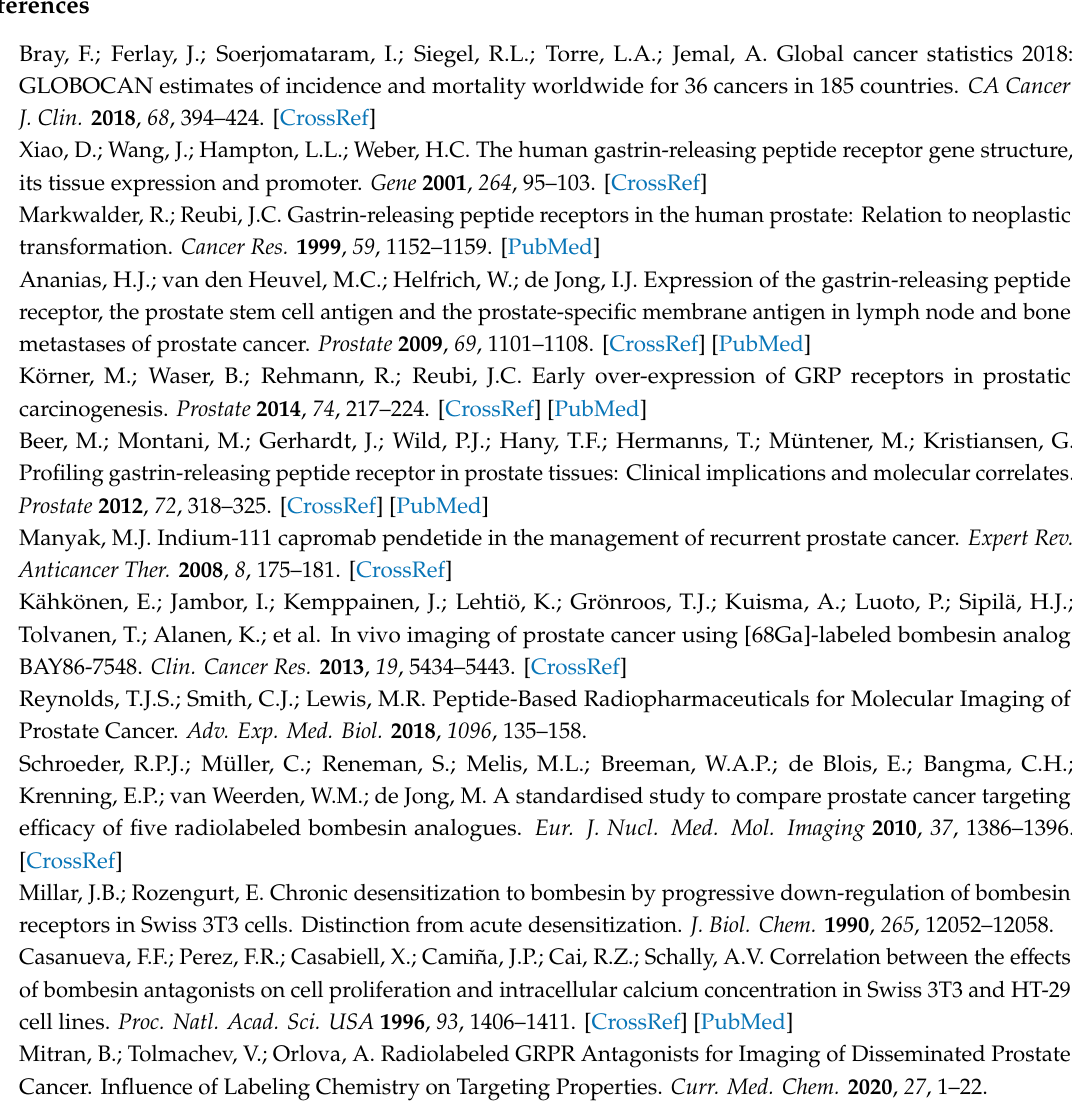
of RM26 after RP-HPLC purification; Figure S3: MALDI-MS spectrum of DOTA-ABD-RM26 after RP-HPLC purification; Figure S4: RP-HPLC elution profiles of the DOTA-ABD-RM26 conjugation reaction; Figure S5: ESI-MS spectrum of DOTA-ABD-RM26 after RP-HPLC purification; Figure S6: SDS-PAGE analysis of recombinant ABD035; Figure S7: MALDI-MS spectrum of recombinant ABD035; Figure S8: SPR sensorgram of ABD035 injected to surface with HSA at six di ff erent concentrations; Figure S9: SPR sensorgram of DOTA-ABD035-RM26 binding to HSA at seven di ff erent concentrations; Figure S10: SPR sensorgram of DOTA-ABD035-Cl binding to HSA at seven di ff erent